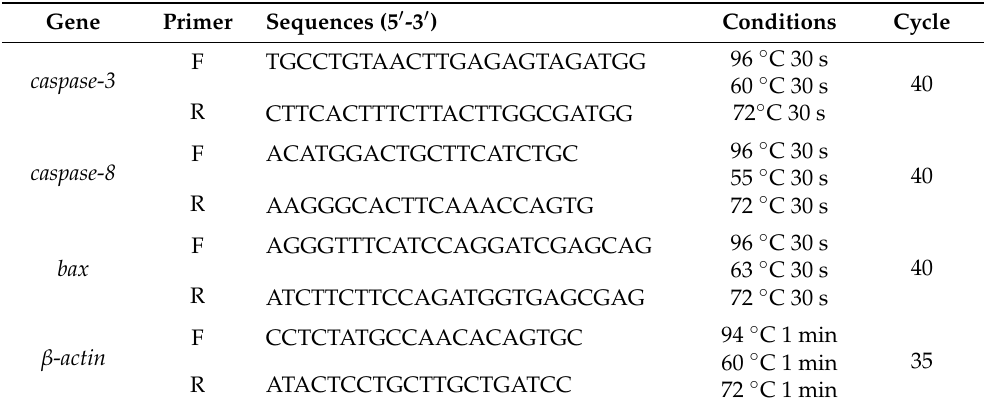
Table 1. Primer set used for PCR